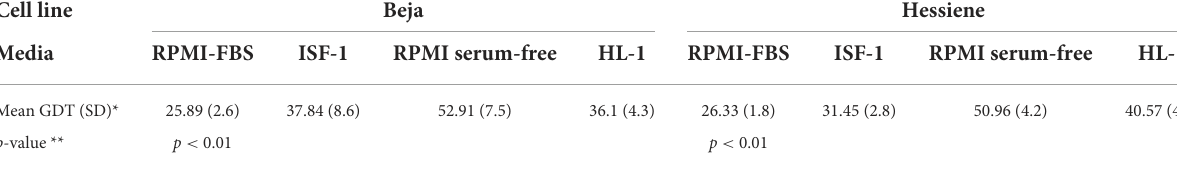
TABLE 1 Generation doubling time (GDT, in hours) of Theileria annulata strains (Beja and Hessiene) grown in different serum-free media and RPMI supplemented with 10% fetal bovine serum (RPMI-FBS). Cell line Beja Hessiene